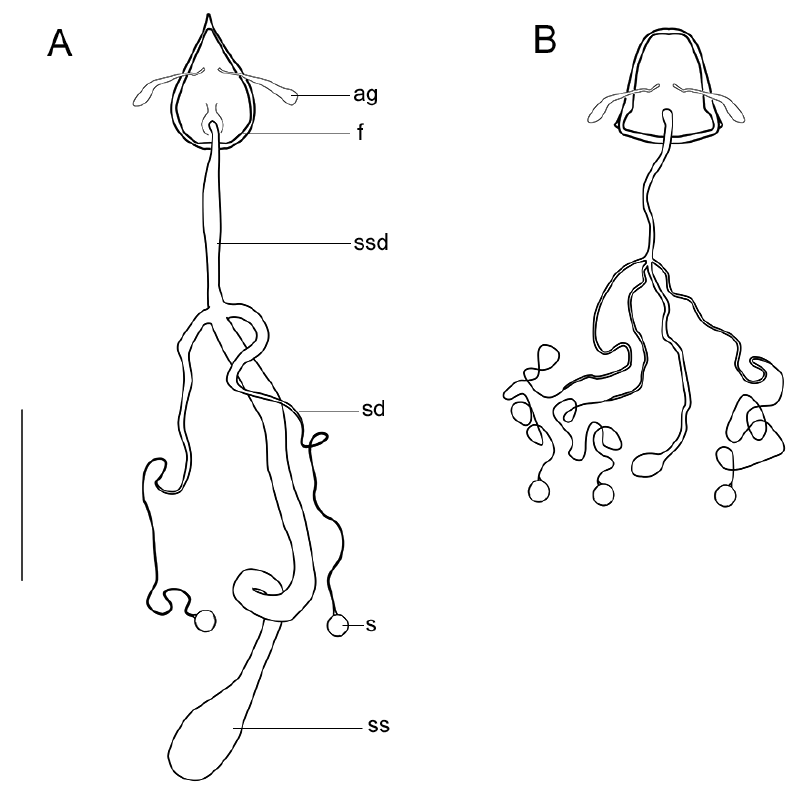
Figure 28. Distal reproductive complex. A Zelothrix yeatesi sp. n. B Sidarena macfarlandi sp. n. Scale line: 0.2 mm. Abbreviations: ac , accessory gland; f , furca; s , spermatheca; sd , spermathecal duct; ss , sper- mathecal sac; ssd , spermathecal sac